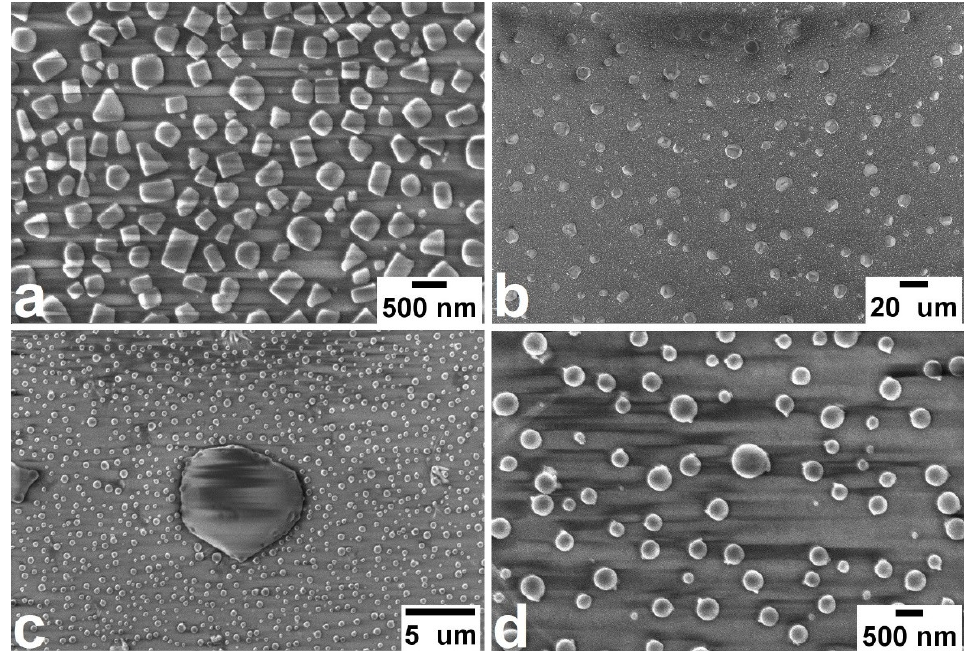
Figure 6. SEM image of the ion-exchanged PTR-M glass sample heat-treated at 350 °C ( a ) and 450 °C ( b – d ; various magnifications) for 3 h.